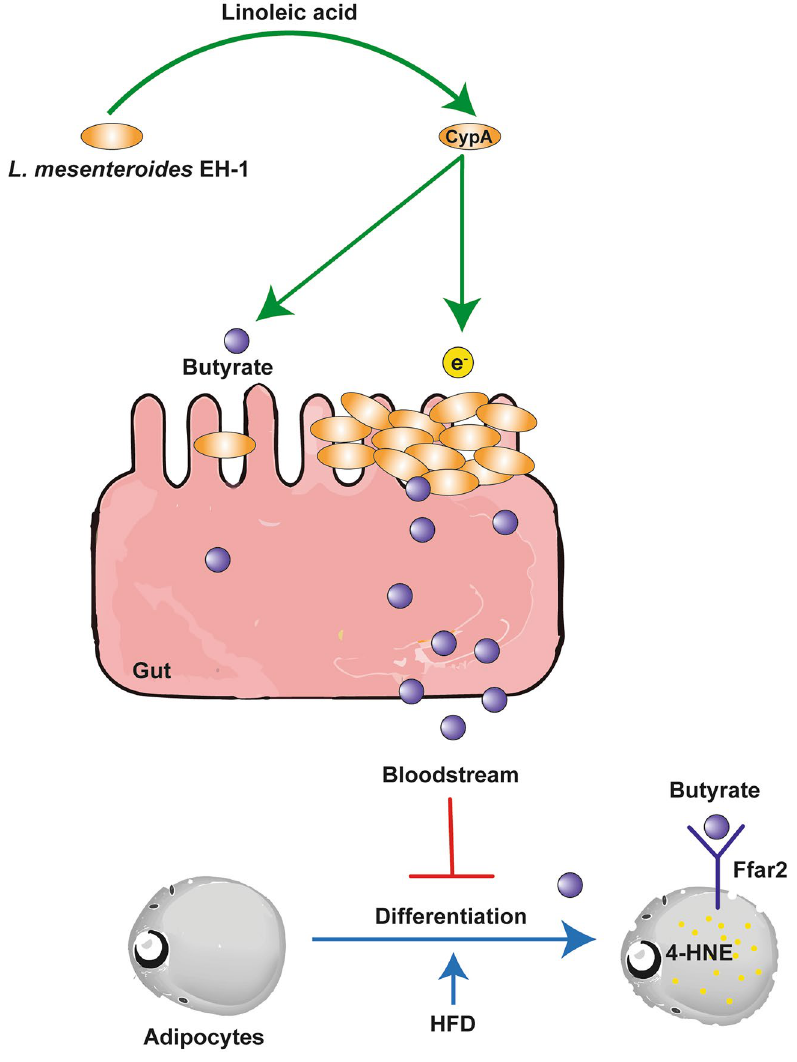
Figure 6. An outline of the actions of L. mesenteroides EH-1 on reduction of HFD-induced accumulation of abdominal fat mass. The L. mesenteroides EH-1 metabolized linoleic acid to yield electrons (e − ) via an intracellular cyclophilin A (CypA)-dependent pathway. Electrons enhance bacterial colonization and sustain high amounts of butyrate in the gut. The butyrate may circule through the bloodstream, bind to the Ffar2 on the surface of adipocytes, limit the formation of 4-HNE during adipocyte differentiation, and lower the HFD- induced accumulation of abodominal fat mass. The Adobe Illustrator 2020 (Adobe, San Jose, CA, USA) was used to make this